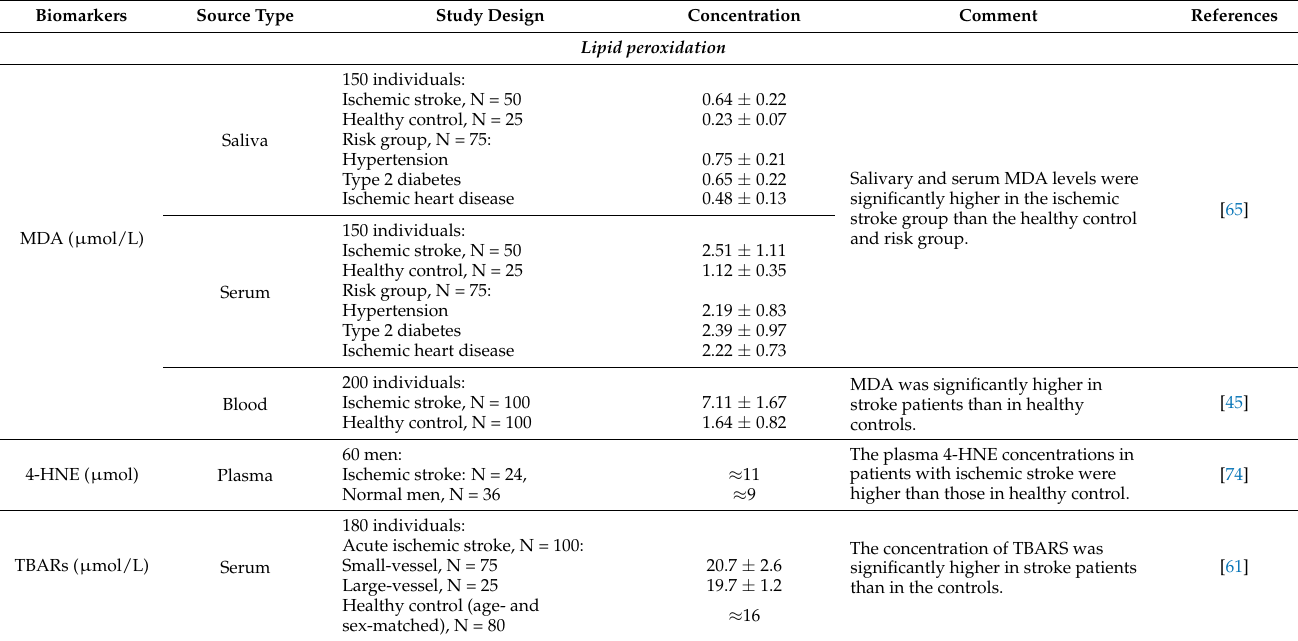
Table 1. Oxidative stress biomarkers levels in acute ischemic